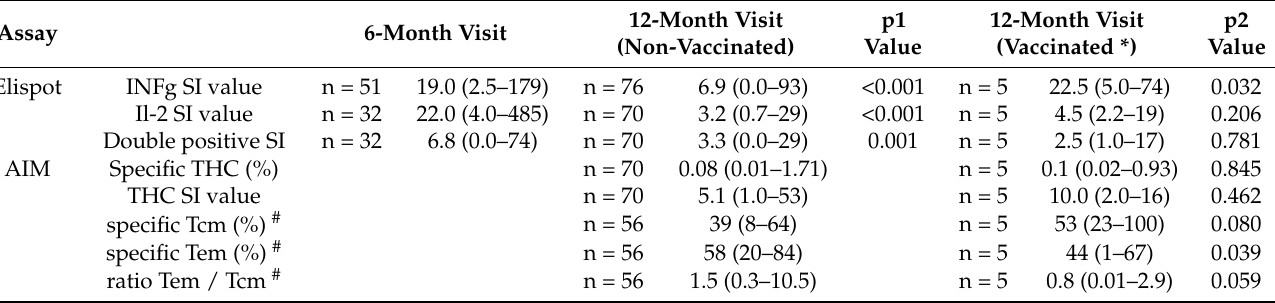
Table 3. Analysis of cellular immunity against SARS-CoV-2 measured by AIM and ELISpot at 6- and 12-month follow-up. Results are given as median values (range). # Values determined for participants with detectable specific T-helper cells (THC) only; INFg, interferon gamma; Il-2, interleukin-2; SI, stimulation index; Tcm, central memory T-helper cells; Tem, effector memory T-helper cells; *, Vaccination at least 14 days before; p1 value, 6-week vs. 6-month visit; p2 value, vaccinated vs. non-vaccinated at 12-month